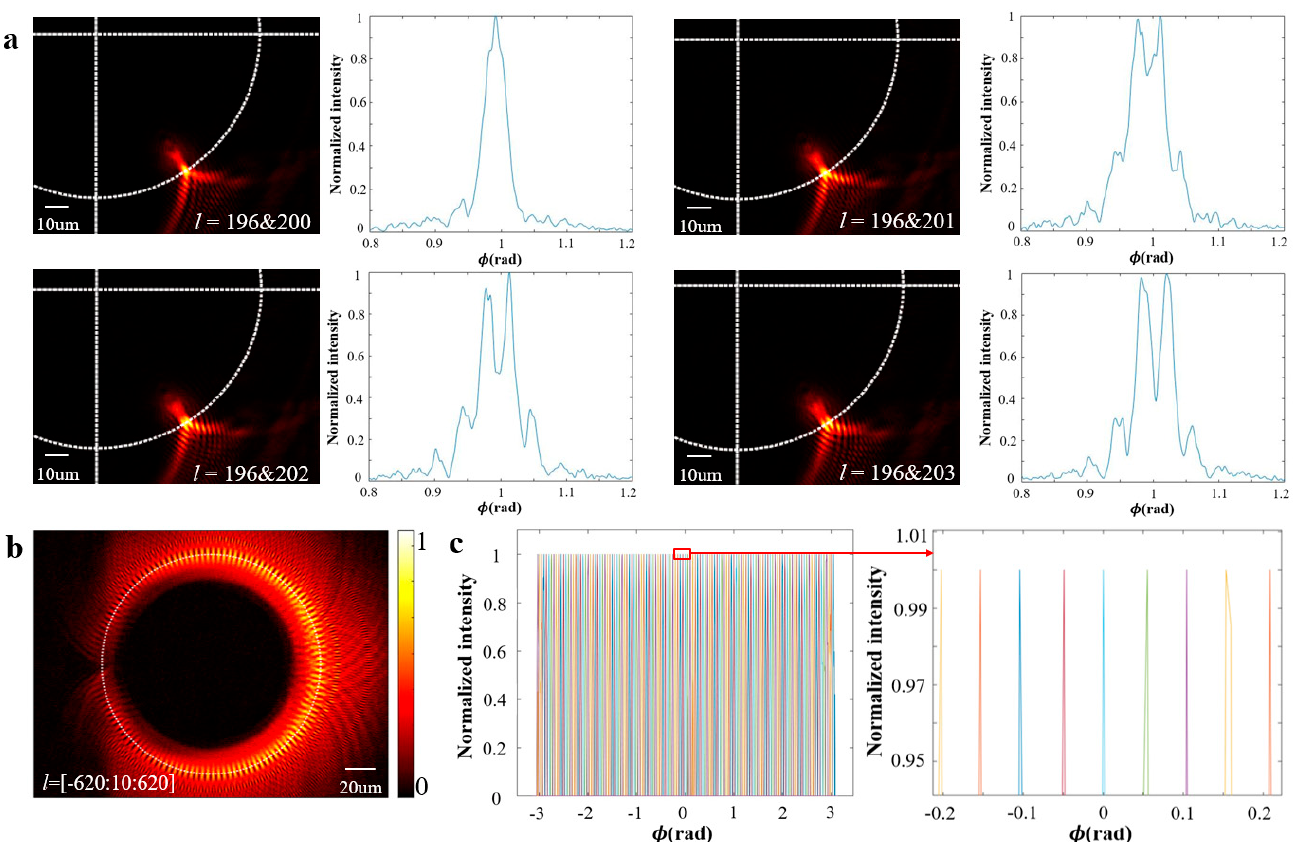
Figure 4. Resolution efficiency of the OSM of wavelength 633 nm. ( a ). Focusing mode of two superimposed OAMs’ modes with different mode intervals simulated by FDTD. The OAMs interval increases from ∆ l = 4 to ∆ l = 7, and the left figure shows the intensity mode of the two topological charge focusing spots, and the right figure shows the intensity curve of the corresponding dashed white line. ( b ). FDTD simulation results of PMT with 124 superimposed OAM modes and mode interval ∆ l = 10. ( c ). Normalized intensity curve along the white dotted round line in